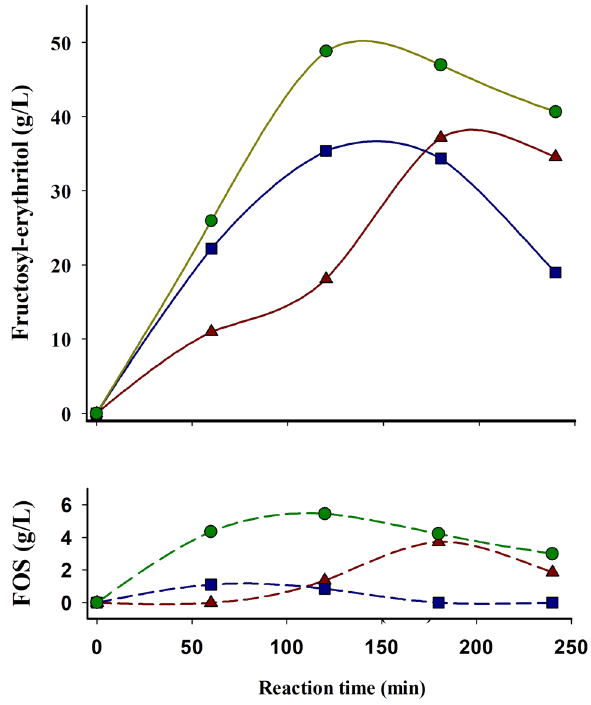
Figure 3. Time course of fructosyl-erythritol and total FOS production by the wild-type Ffase and the indicated variants. Reaction mixtures (1.5 ml) incubated at 50 ºC contained 10 U ml −1 of the referred enzymatic variant (previously purified), 200 mg ml −1 sucrose, and 500 mg ml −1 erythritol in 0.1 M sodium acetate pH 5.5. The constituents of the reaction mixtures were quantified in duplicate at the indicated times by HPLC-ELSD with standard deviation less than 5%. Data obtained with the wild-type (brown triangles), N254T (green circles) and N254D (blue squares) variants are